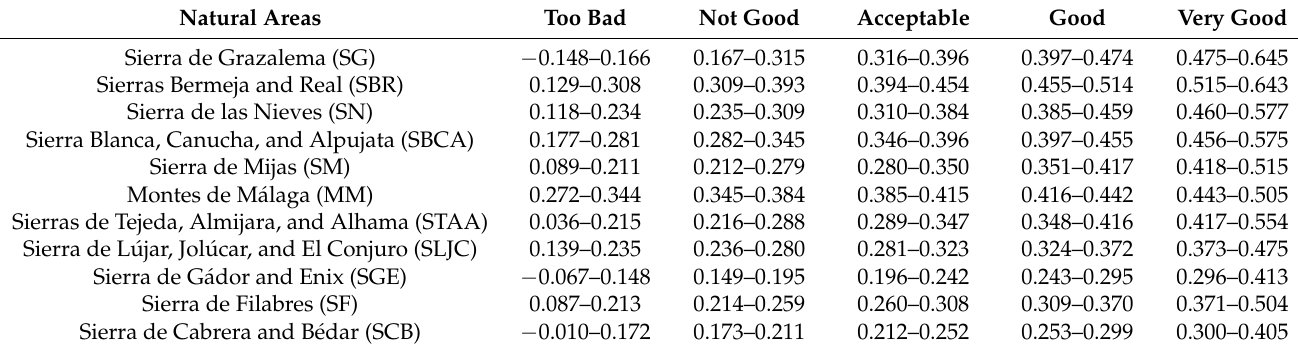
Figure 6. Annual distribution of Standardized Precipitation Index (SPI) and annual precipitation. Sorted according to defined time series, see the reference in Table 5. Clarification of the legend. The years of the time series, for comparison, are ordered on all graphs with the same sequence of years: from very wet to very dry. Own elaboration based on data of the portal https://monitordesequia.csic.es/ (accessed on 21 December 2022) for the SPI and Automatic Hydrological Information System (SAIH) Hidrosur, Autonomous Community of Andalusia (Spain) for precipitation data http://www.redhidrosurmedioambiente.es/saih/ (accessed on 21 December 2022). Table 7. Average values of the vegetation indices applied (NDVI, NDWI, and EVI) for the assessment of the state of vegetation